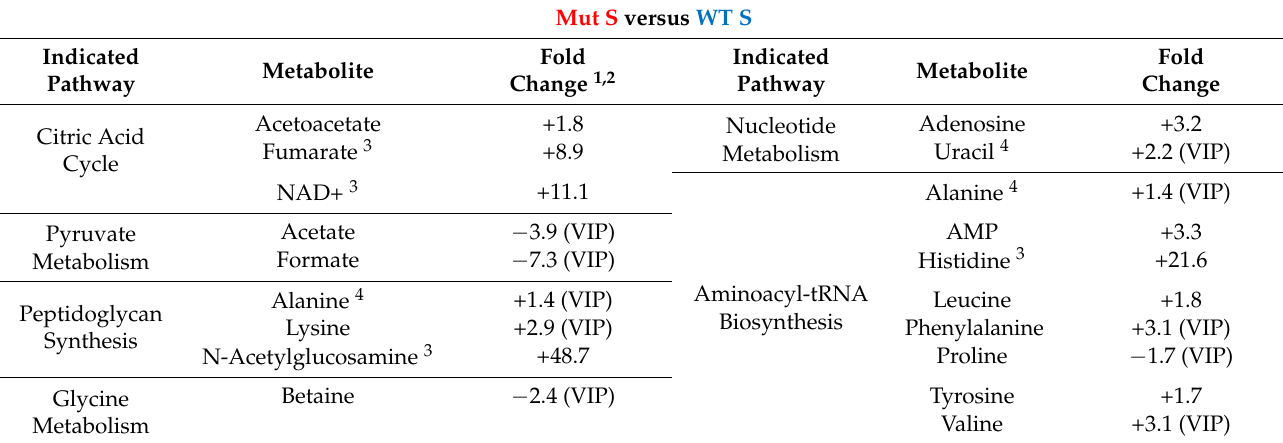
Table 4. Fold change of statistically significant metabolites in their corresponding metabolic pathways for the stationary phase of mutant versus wild